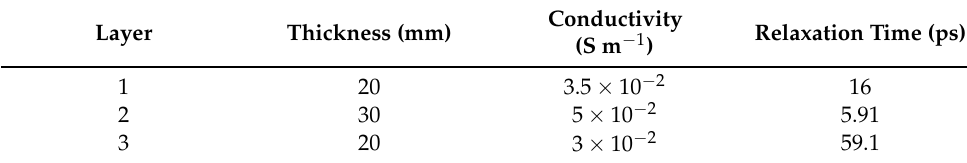
Table 1. Geometric and electrical parameters of the three-layer dielectric slab.